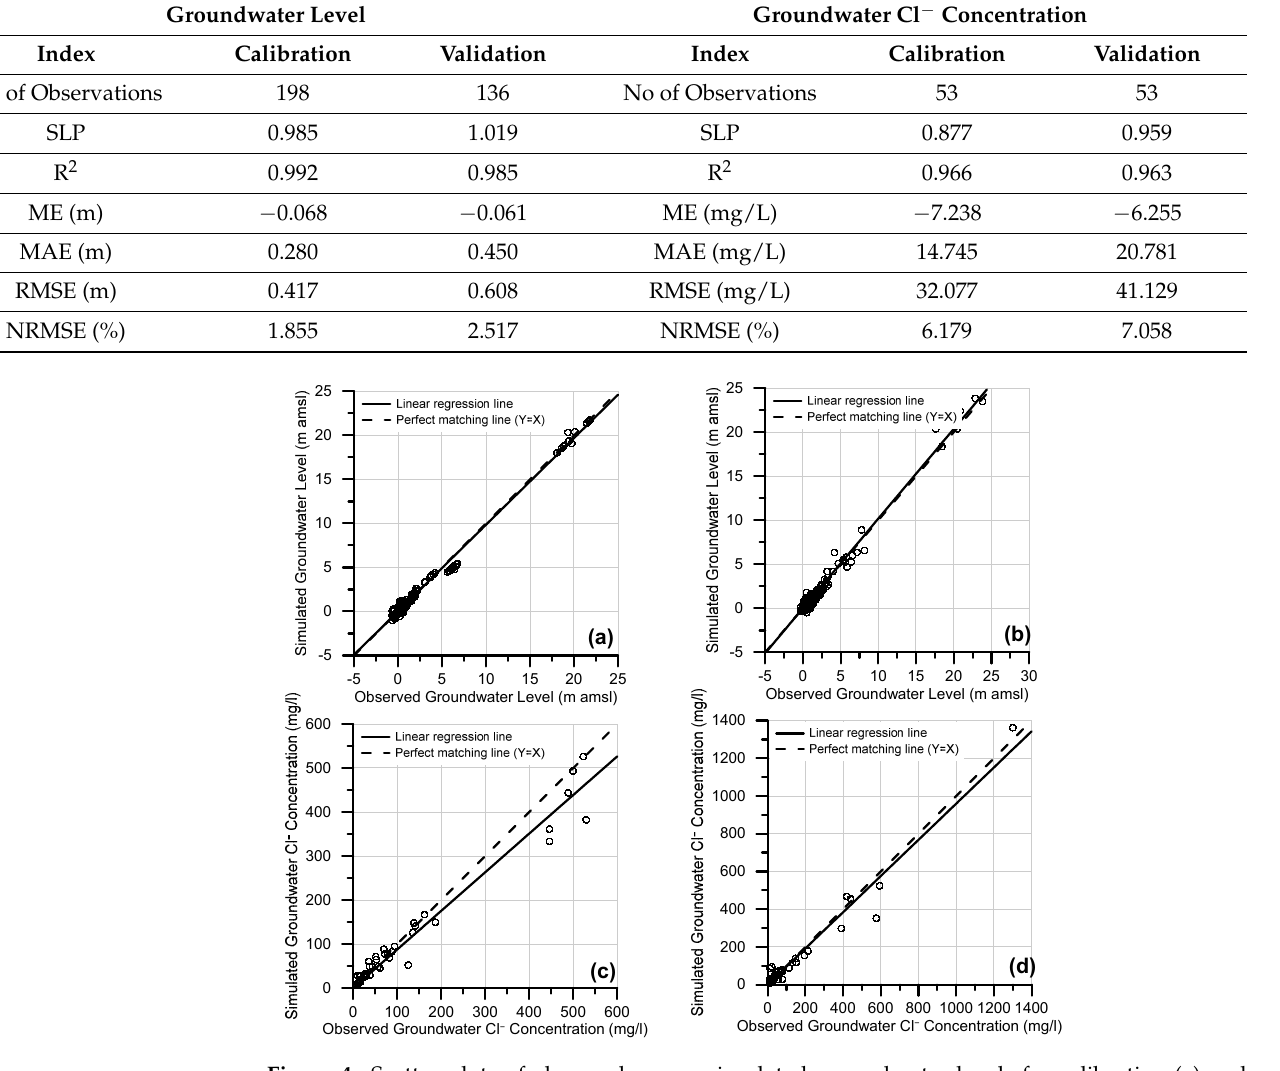
Figure 4. Scatter plots of observed versus simulated groundwater levels for calibration ( a ) and validation ( b ) periods. The corresponding plots for groundwater chloride concentrations are also presented for calibration ( c ) and validation ( d ).